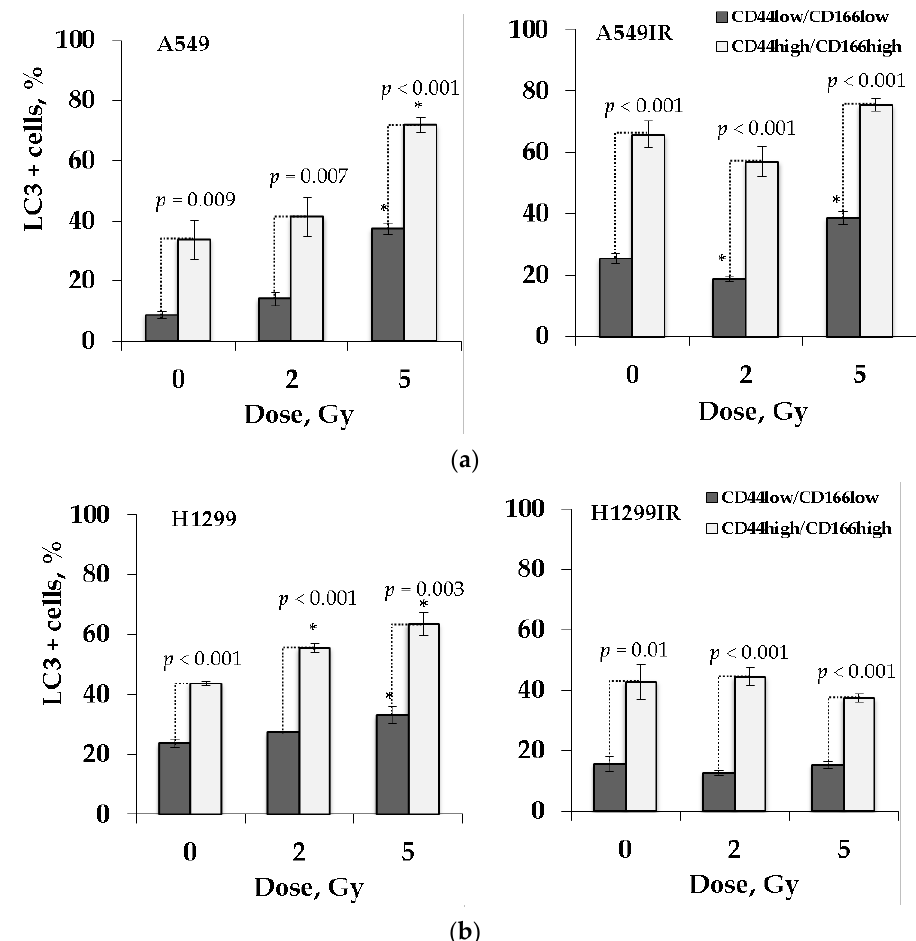
Figure 8. The proportion of LC3 positive cells in CD44low/CD166low and CD44high/CD166high populations of MFR-surviving and their parental NSCLC cells 24 h after exposure to 2 Gy and 5 Gy of X-ray: A549IR and A549 cells ( a ); H1299IR and H1299 cells ( b ). * p < 0.05. Data are means ± SEM of more than three independent experiments.